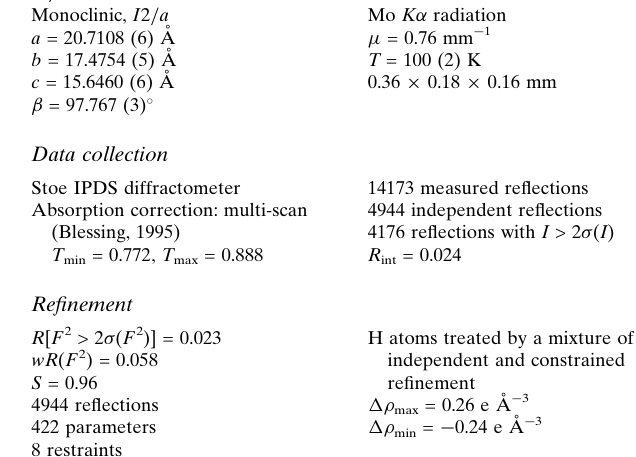
Key indicators: single-crystal X-ray study; T = 100 K; mean (cid:1) (C–C) = 0.002 A˚; disorder in solvent or counterion; R factor = 0.023; wR factor = 0.058; data-to- parameter ratio = 11.7.